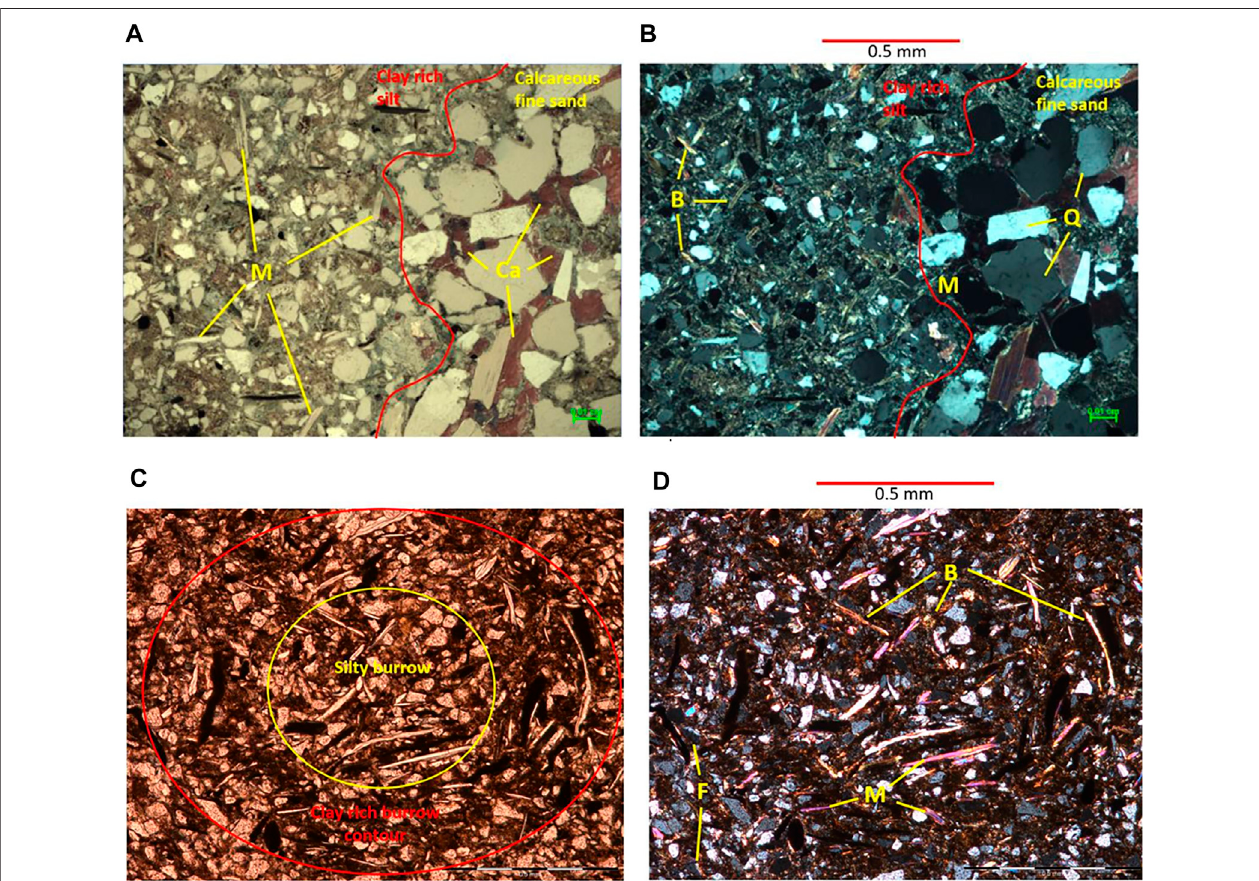
FIGURE 9 | Variegated and blocky mudstone facies from the Washita-Fredericksburg interval, MPC 34-1 well 1,482.2 m (4,863.0 ft). (A) PPL photomicrograph showing distinct contact between fi ne-grained and coarser lithologies due to burrowing. (B) CPL image showing quartz, mica, and minor amounts of biotite. Variegated andblockymudstonefacies,clayrichthinsection,fromtheWashita-FredericksburgintervalintheMPC34-1well,1,478.5 m(4,850.6 ft). (C) PPLimageshowingaclay- rich, lined horizontal burrow. (D) CPL microphotograph showing muscovite (M) and biotite (B) with some albite and microcline silt (F) with chaotic sorting.